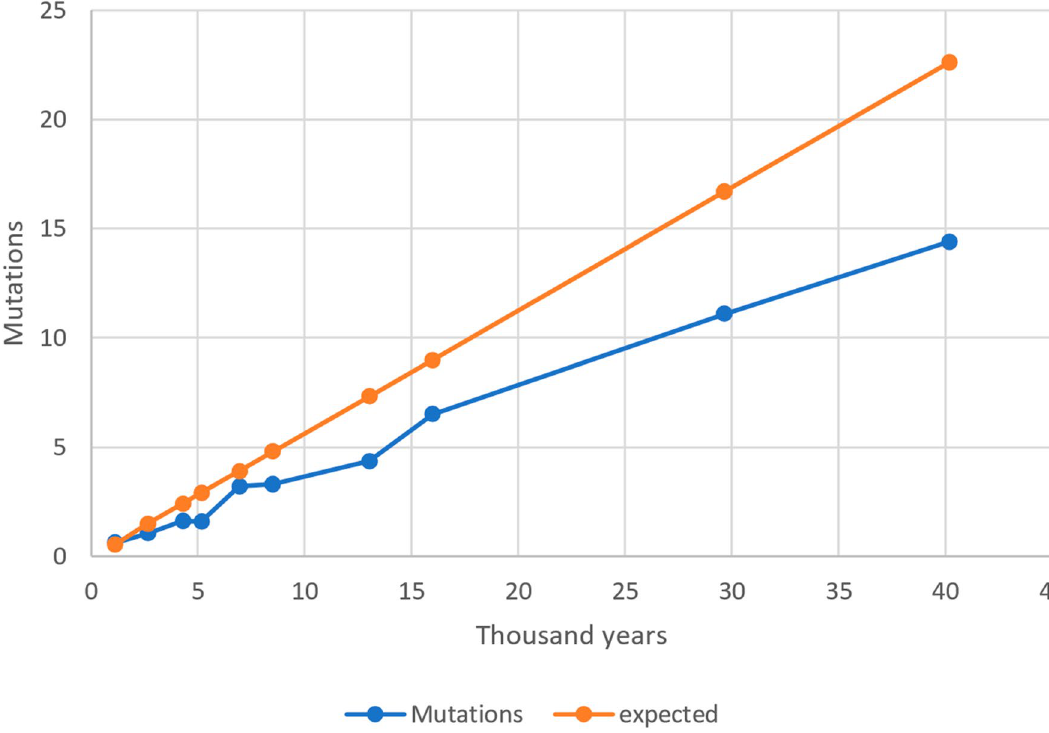
Figure 1. Observed and expected mean number of mutations accumulated along periods on the y-axis and time measured in thousand years on the